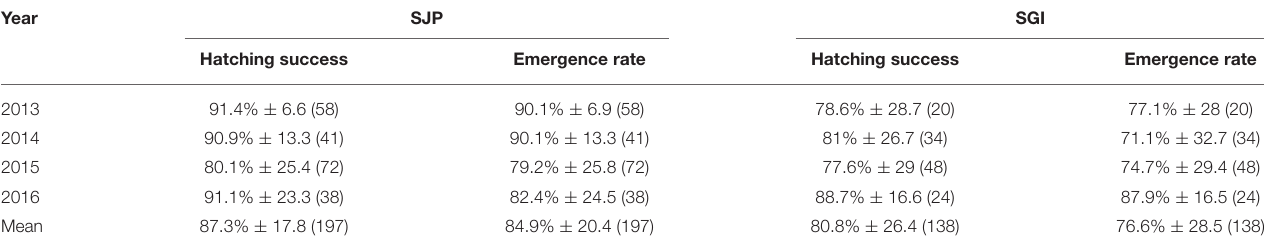
TABLE 2 | Average hatching success and emergence rate for undisturbed nests (not affected by predation and storm-related impacts), with their respective standard deviations and number of nests in parenthesis, at SJP and SGI throughout the study